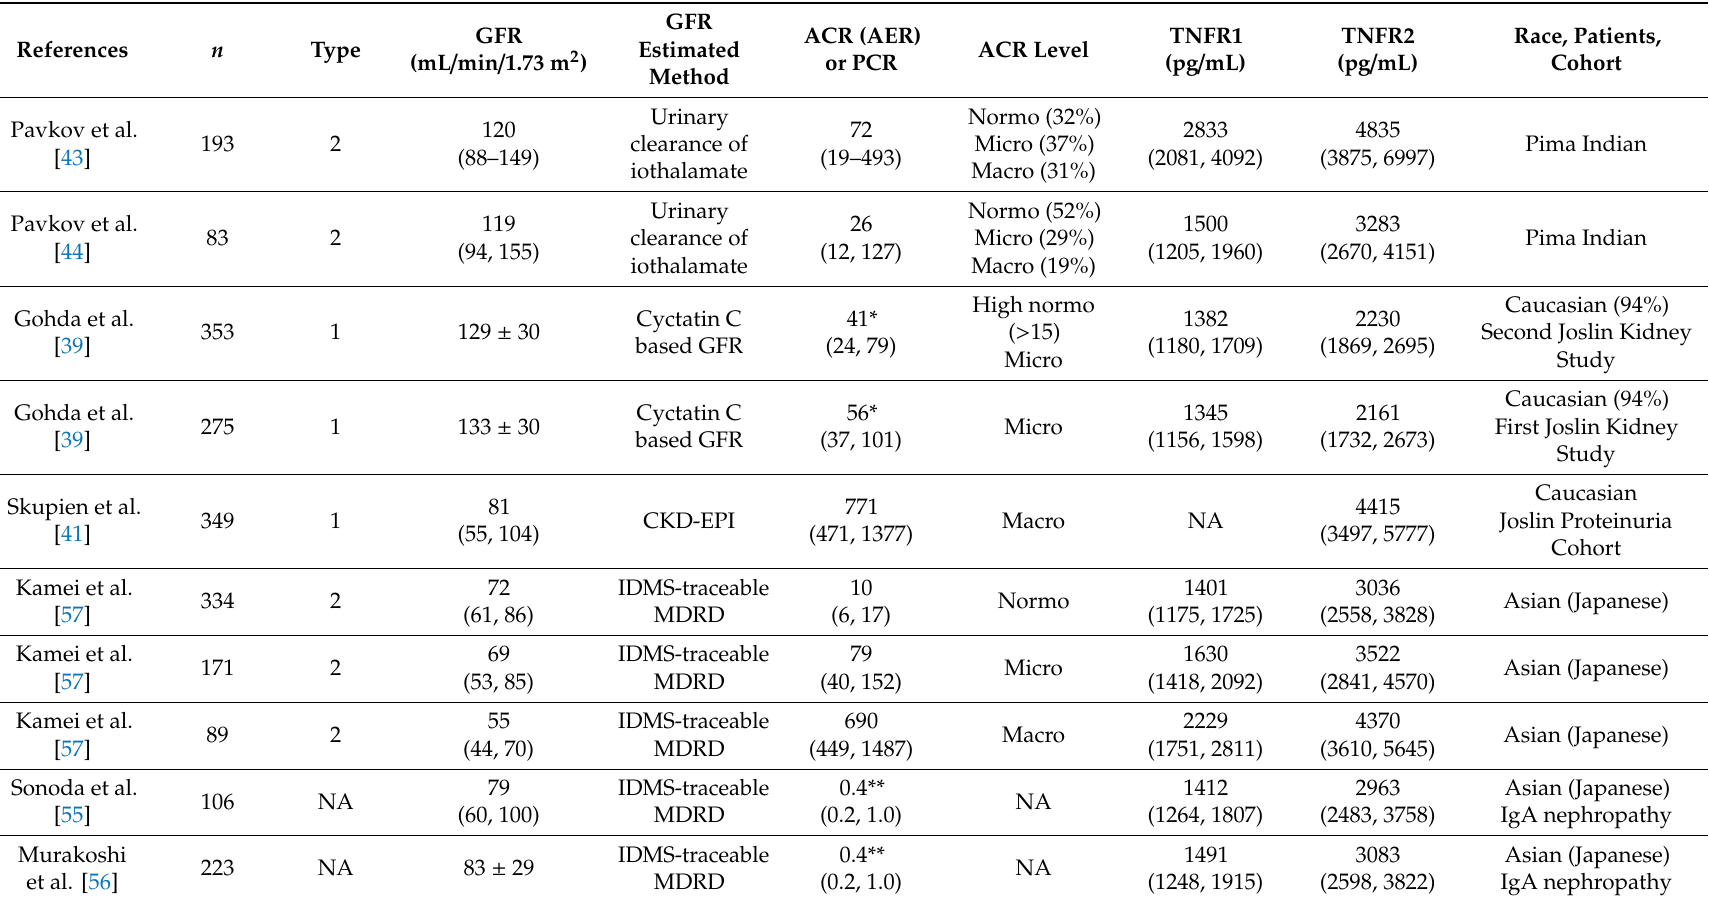
Table 3. Circulating tumor necrosis factor receptor levels among patients with diabetes and IgA